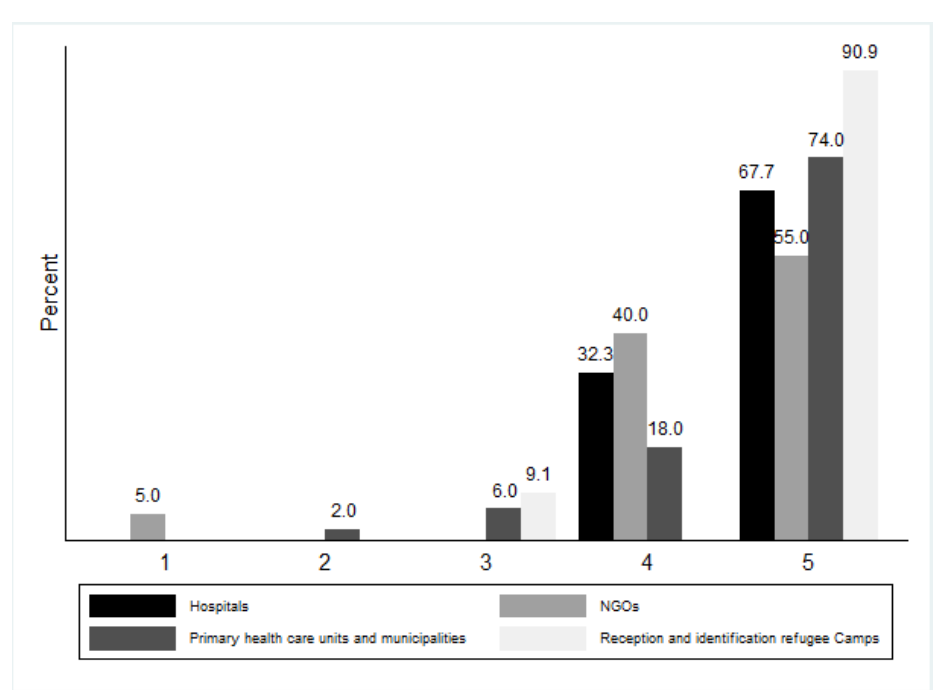
Figure 2. For Module 3, degree of agreement with the phrase “The speaker’s presentation was clear” by work experience and profile.